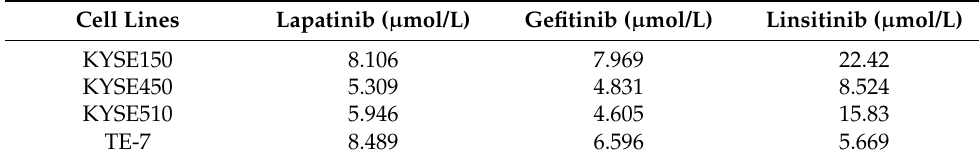
Figure 1. The proliferation inhibition effects of lapatinib, gefitinib, and linsitinib alone or in combina- tion. ( a ) EGFR, HER2, and IGF-1R expression levels on four ESCC cells analyzed by western blot. ( b ) Effects of lapatinib, gefitinib, and linsitinib alone on the proliferation of four ESCC cells measured by MTT assays. ( c ) Effects of lapatinib or gefitinib in combination with linsitinib at the indicated concentrations on the proliferation of four ESCC cells measured by MTT assays. ( d ) The CI values of lapatinib or gefitinib in combination with linsitinib, calculated by using the Chou–Talalay method. All the results were from three independent experiments and are expressed as the mean ± SD. Table 1. The IC50 values of lapatinib, gefitinib, or linsitinib alone against four ESCC